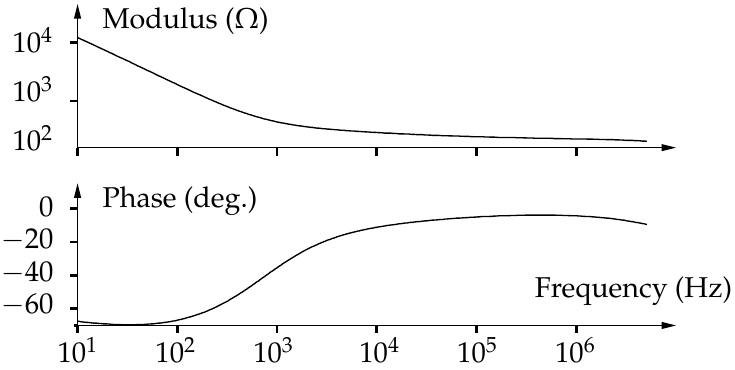
Figure 1. Impedance of bluefin tuna muscle measured using a digital impedance analyzer ( MFIA from Zurich Instruments AG, Switzerland).